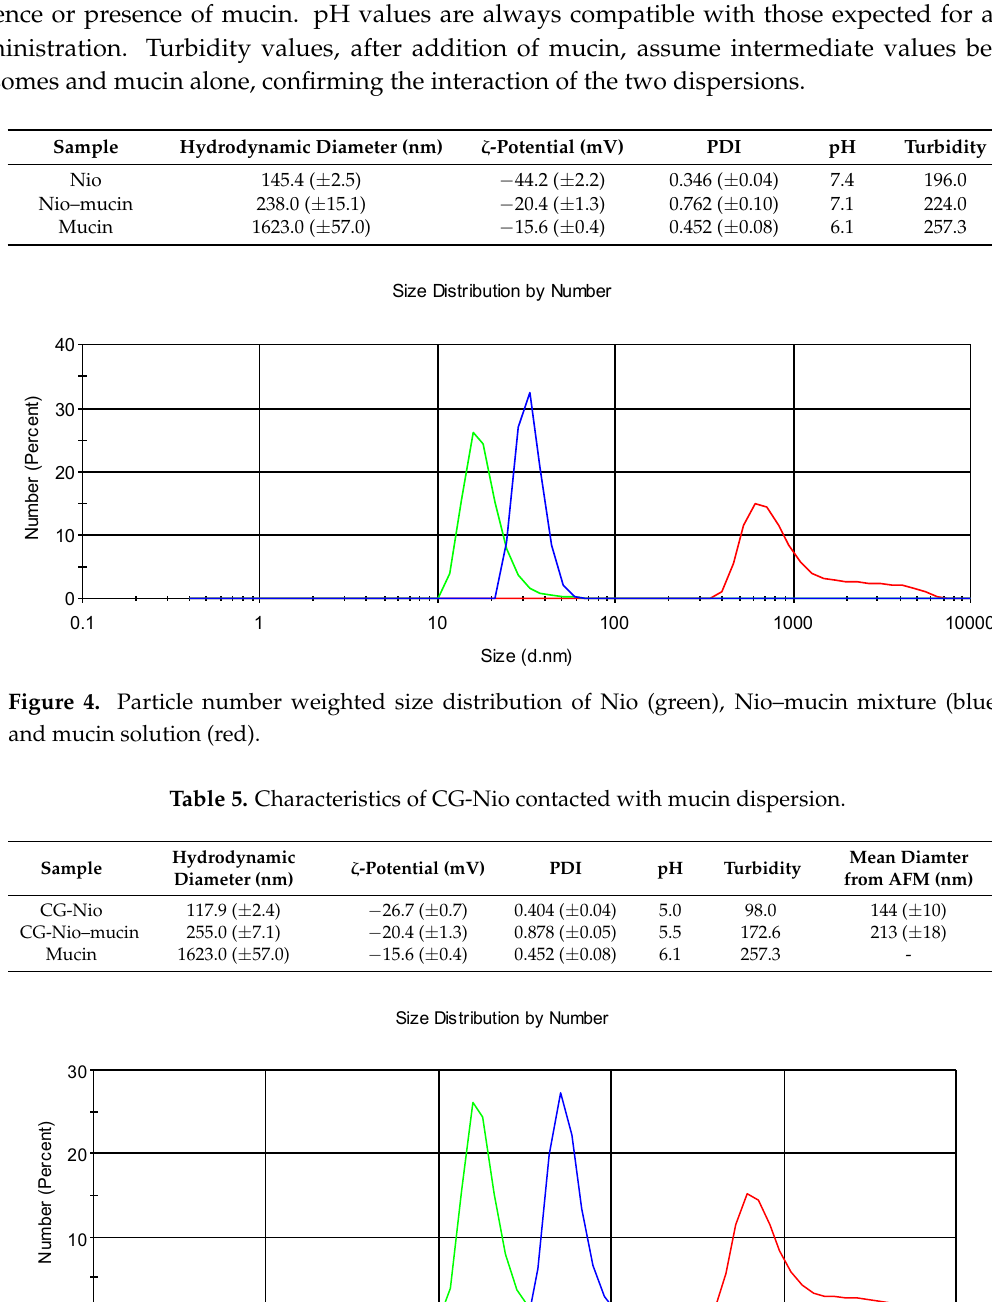
Table 4. Parameter measurements after Nio contacted with mucin.